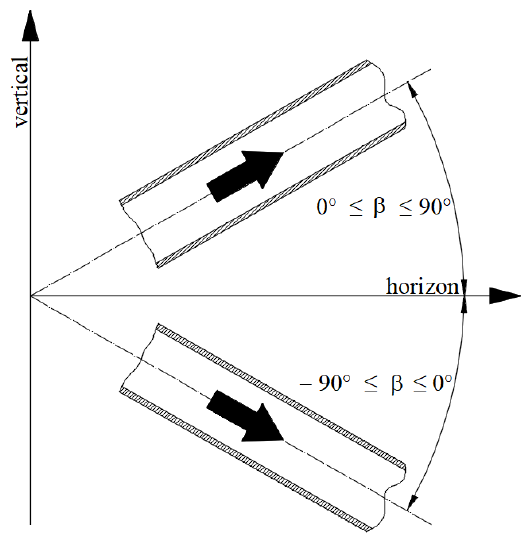
Figure 4. Definition of pipe slope angle (adapted from [49]).